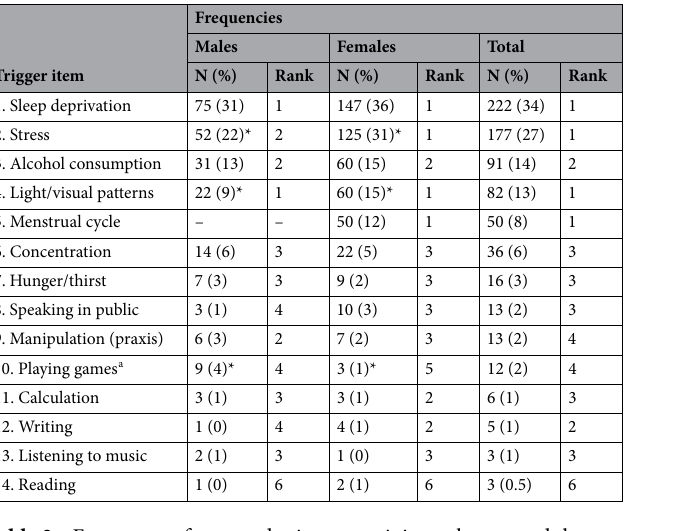
Table 2. Frequency of reported seizure precipitants by sex and the most common importance ranking. a Note that this may have been interpreted as either playing physical sports or playing video games. *Sex difference, p < 0.05.